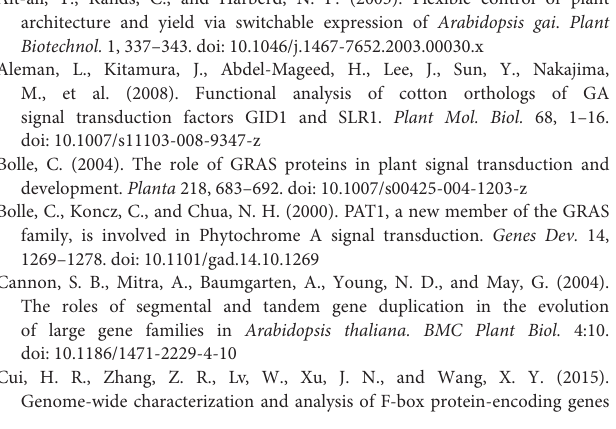
Table S2 | Comparison of MdGRAS genes in different species.